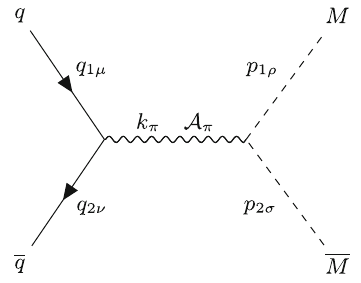
Fig. 4 Total cross section for the production of spin-0 monopoles via the PF process as a function of the monopole mass M at